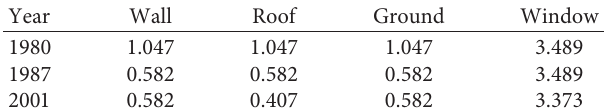
Figure 5: Changes in U-value by year. Table 7: U-values in different years (W/m 2